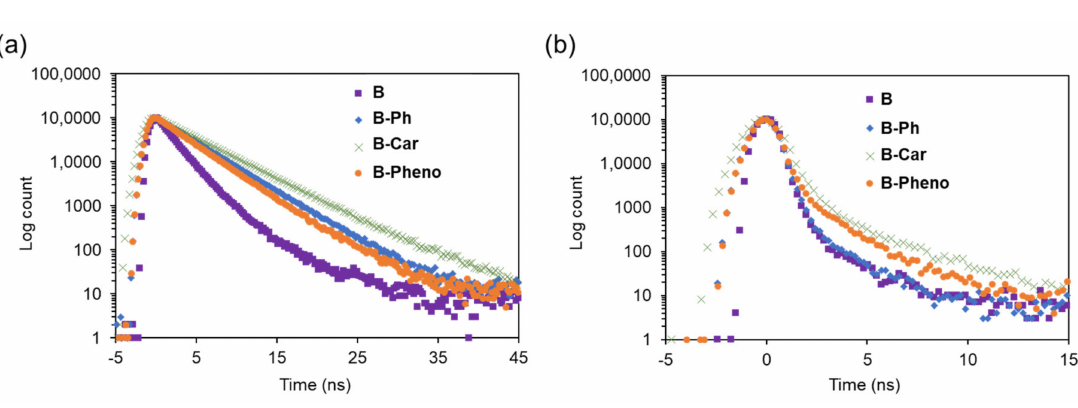
Figure 8. Fluorescence decay spectra of ( a ) B, B-Ph , B-Car , and B-Pheno in THF solution and ( b ) B, B-Ph , B-Car , and B-Pheno on 0.75wt% Pt-TiO 2